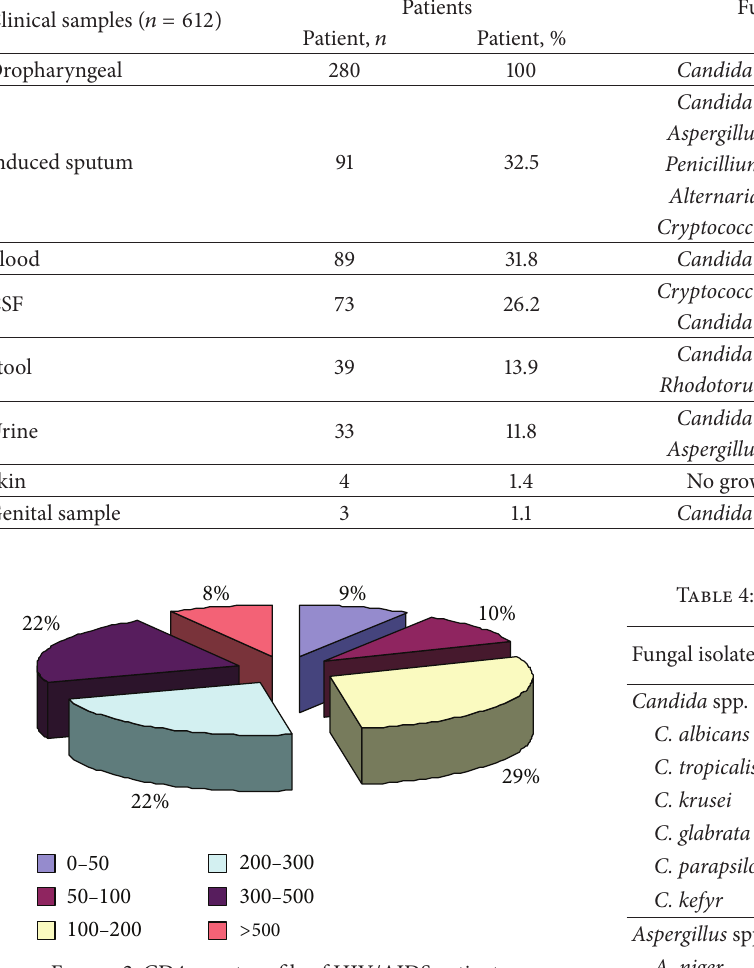
Figure 2: CD4 count profile of HIV/AIDS patients.